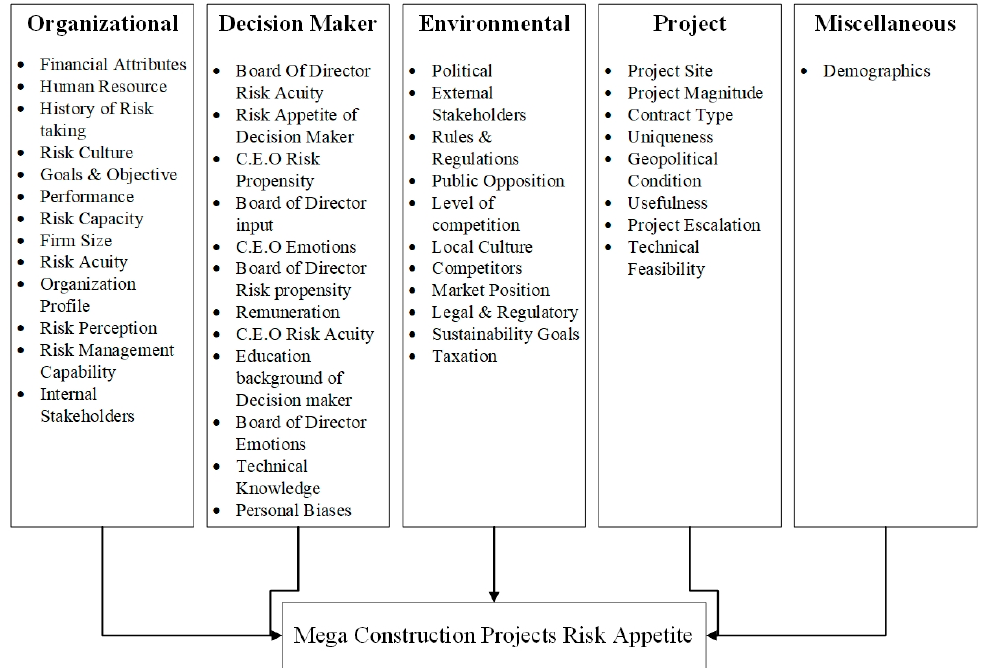
Figure 13. Framework of factors affect risk appetite in mega construction projects.